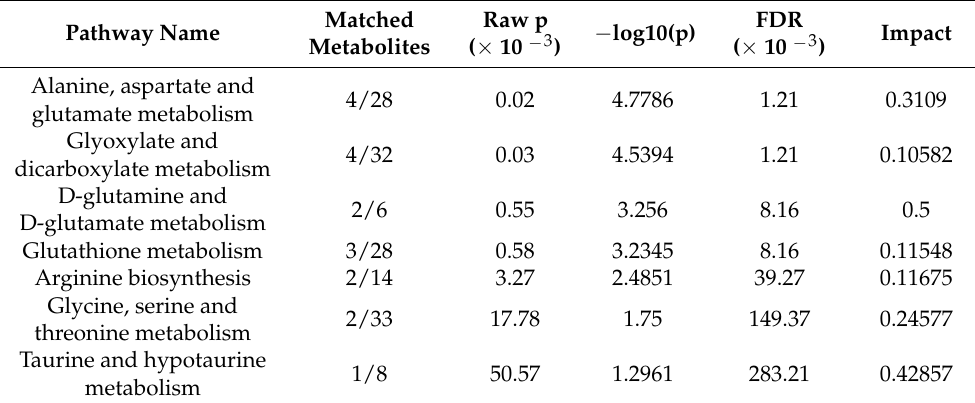
Table 3. Metabolic pathway analysis of metabolites identified by 1 H-NMR.